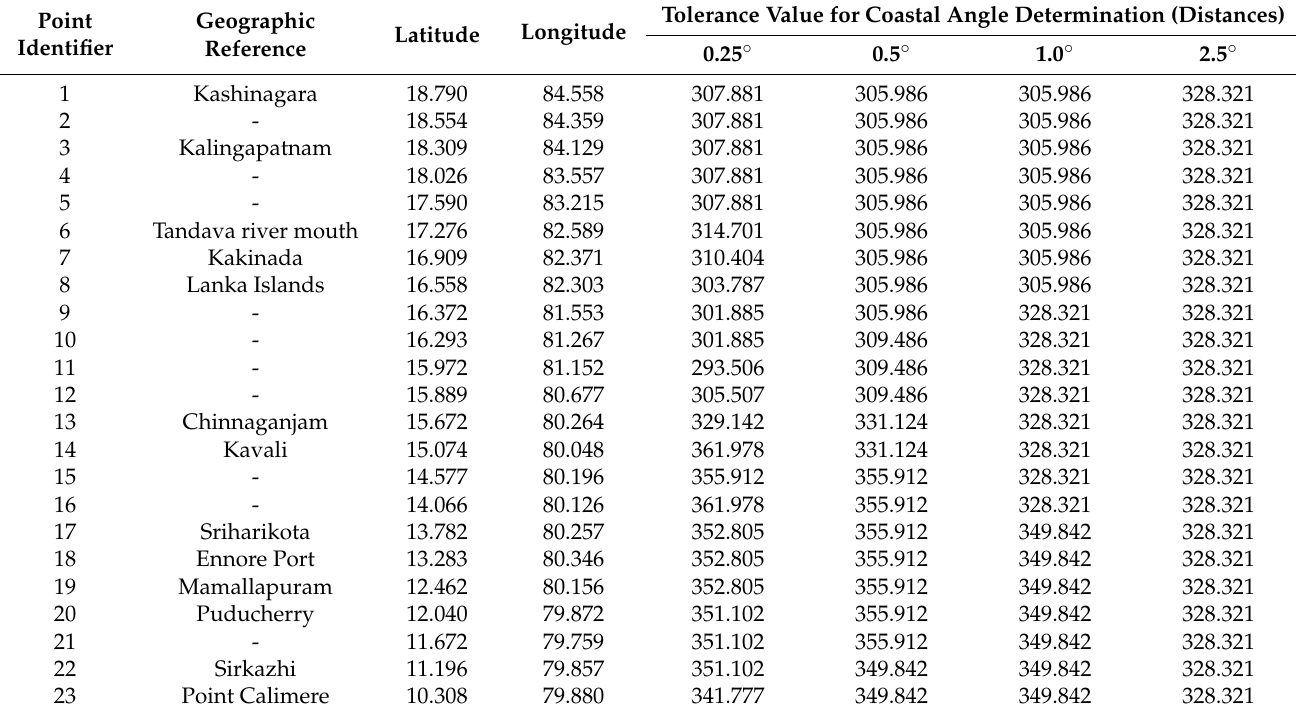
Table 2. Values of Coastal Angles corresponding to different tolerances at each coastal